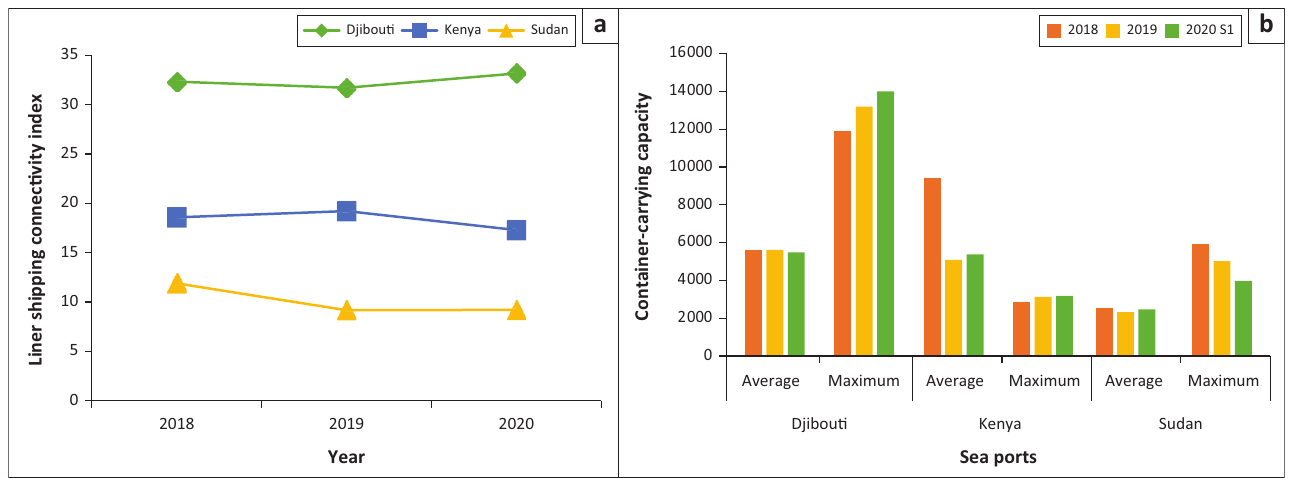
FIGURE 6: (a) Liner shipping connectivity index and (b) container-carrying capacity (20-foot equivalent units) per container